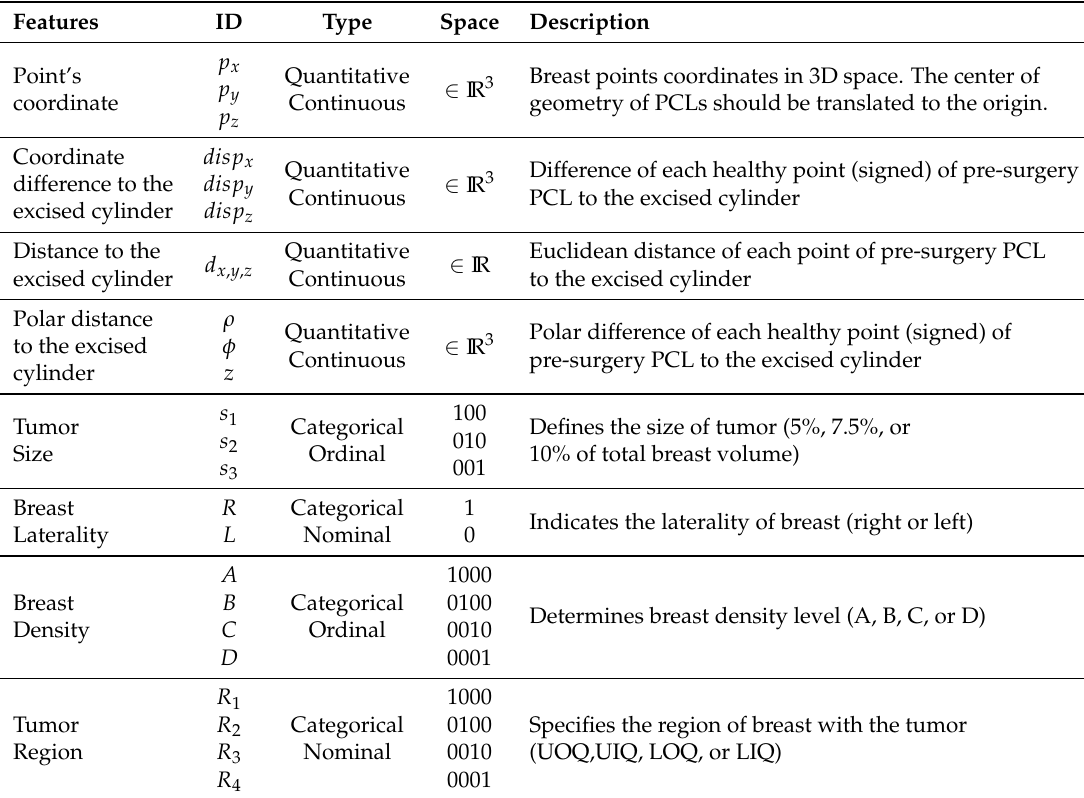
Table 4. Description of features used in the regression models to predict breast deformations after